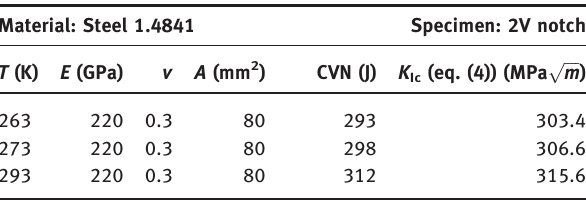
Table 3: Experimentally determined impact energy and calculated fracture toughness. Material: Steel  . 